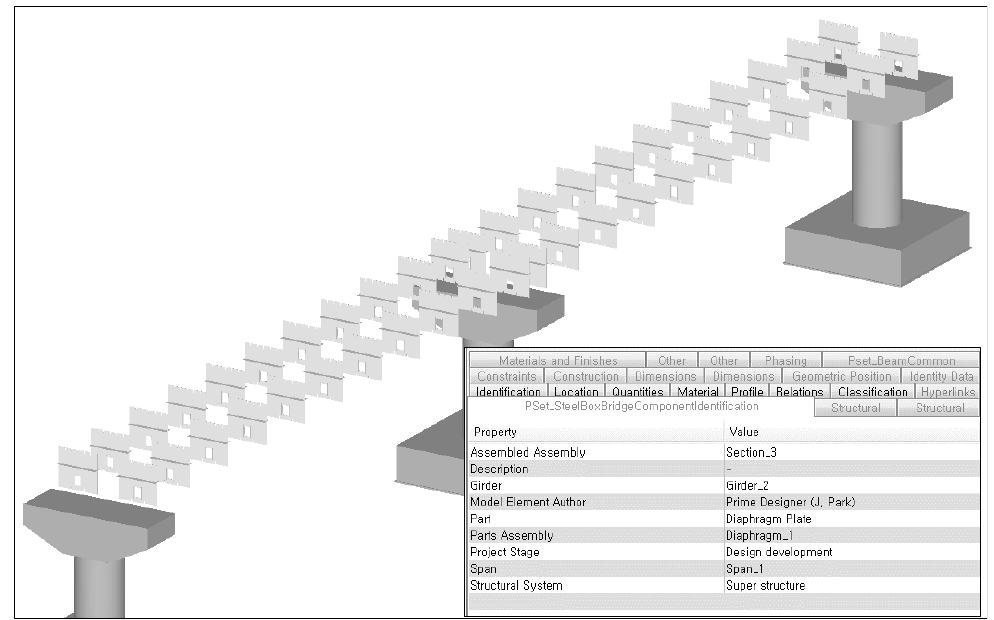
Figure 16. Query result for extracting all the diaphragms from the bridge model (the pier objects were deliberately added for check the locations of the diaphragms).